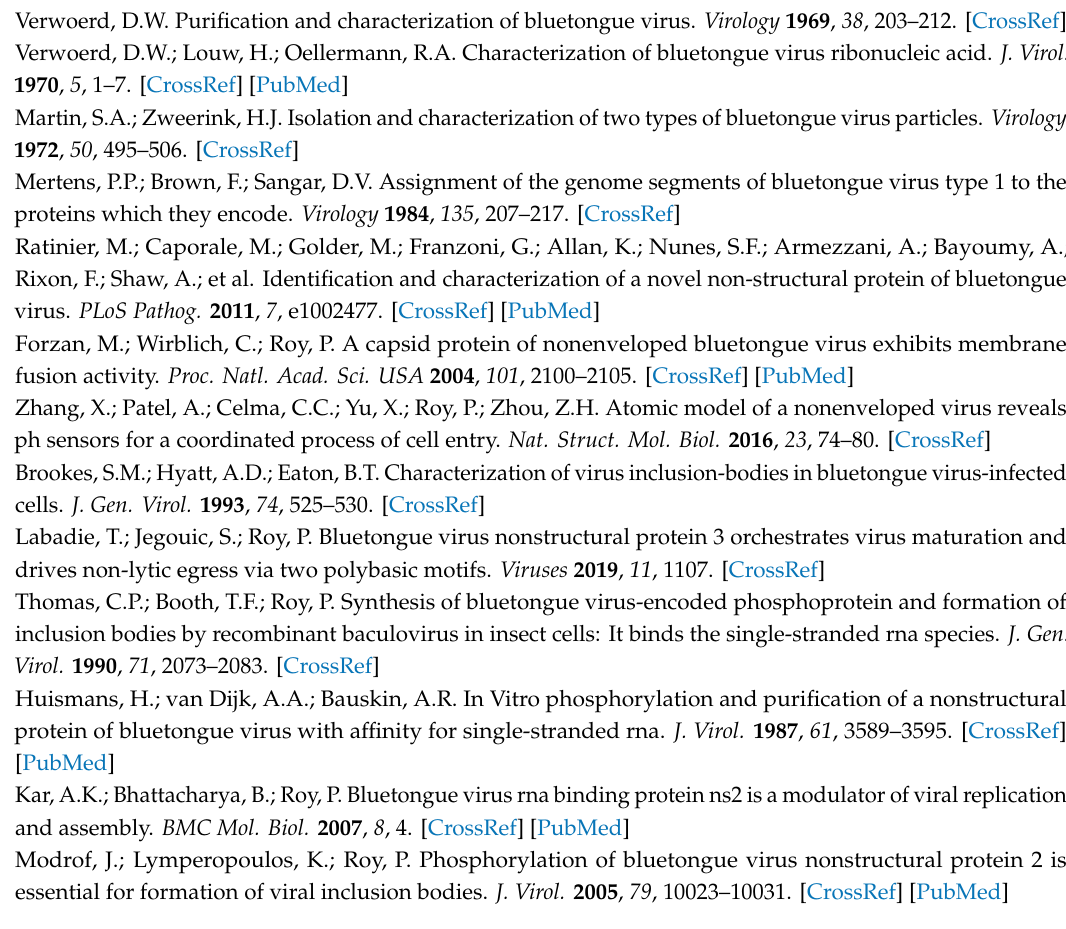
Figure S1: Western Blot detection of the expression of the viral proteins NS2, VP5, VP6 and host cell GAPDH, Figure S2: Western Blot detection of the expression of the viral proteins NS2, VP5, NS3 and host cell GAPDH. Video S1: 3D projection of the VIB localization of NS2 (red) and NS3 (magenta) in BTV infected cells 9 h.p.i. Video S2: 3D projection of the VIB localization of VP5 (green) and NS3 (magenta) in BTV infected cells 8.5